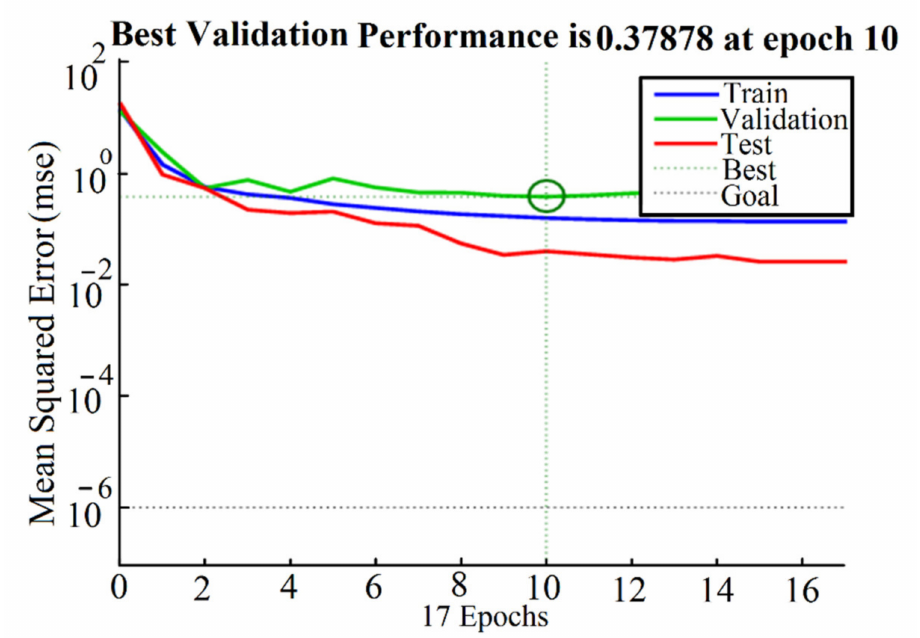
Figure 4. Training errors of the ANN used in bonding strength prediction.